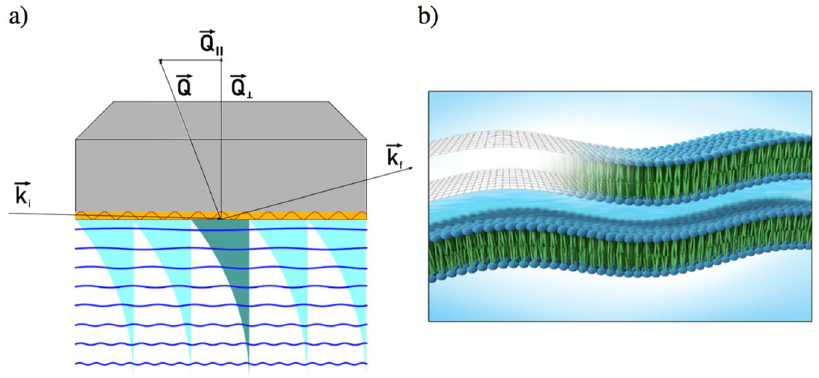
Figure 3. ( a ) Depiction of the geometry of a GINSES experiment. Unlike reflectometry, the incident and outgoing angle differ, which means the total Q-vector is not perpendicular to the surface. Note: the incoming neutron beam passes through the Si-block before scattering on the phospholipid membrane. The intensity of the evanescent wave penetrating the sample is shown as a blue exponentially decaying wave into the sample. In order to illustrate the effect of the resonator (yellow layer) the standing neutron wave (red sinusoidal line) is shown. The evanescent wave in the absence of the resonator is shown in a darker colour, the additional intensity is shown by the lighter evanescent waves penetrating the sample layers (blue wavy lines). ( b ) Sketch of the sample structure.